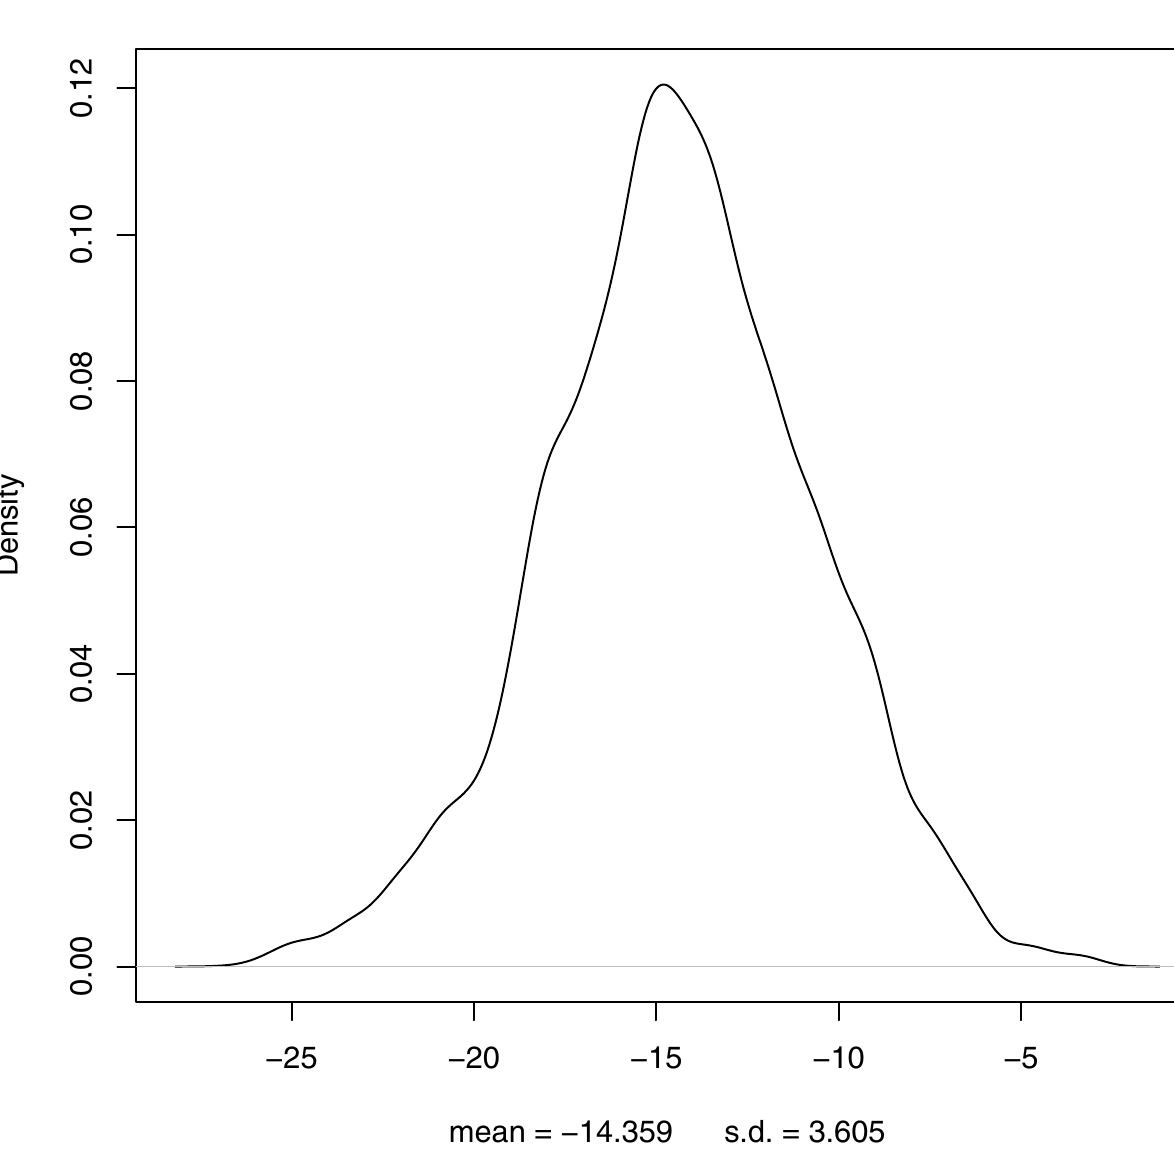
Fig 1. Predictive posterior distribution of the average treatment effect from the doubly-robust model.